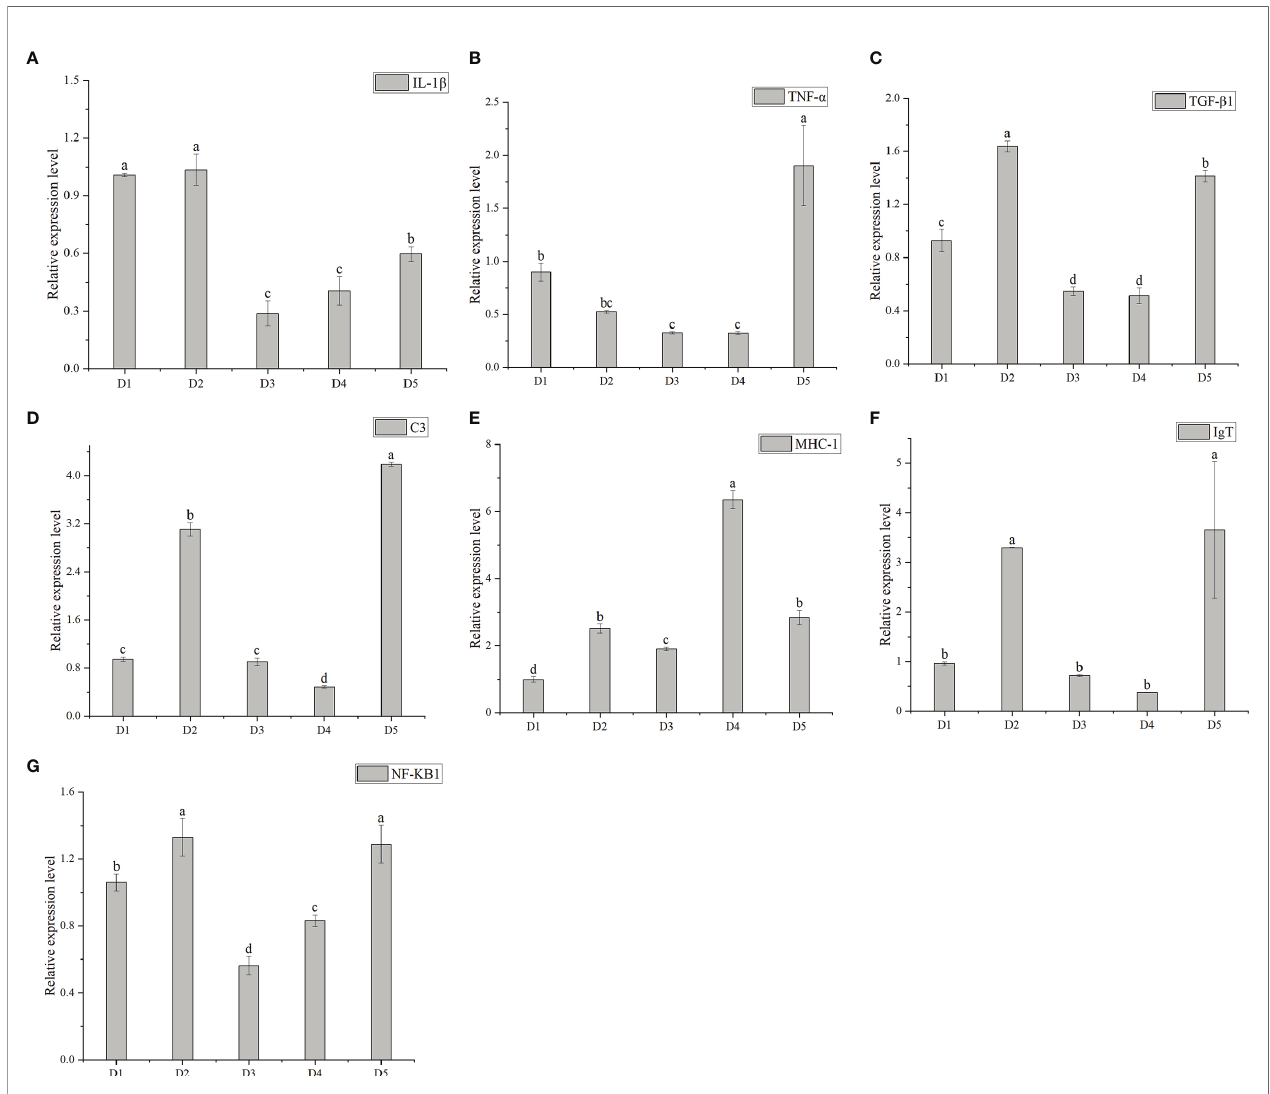
FIGURE 5 | The relative expression of interleukin- 1 b (IL- 1 b ) (A) , tumor necrosis factor (TNF- a ) (B) and transforming growth factor- b (TGF- b 1) (C) , complements (C3) (D) , major histocompatibility complex (MHC- 1) (E) and immune globulin T (IgT) (F) and nuclearfactor kappa-B (NF-KB1) (G) genes of greater amberjack after transportation under different densities. Different letters above bars indicate signi fi cant differences at the 0.05